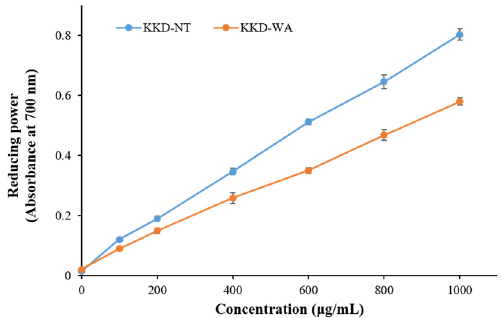
Figure 2. Reducing power activity of KKD-NT and KKD-WA.